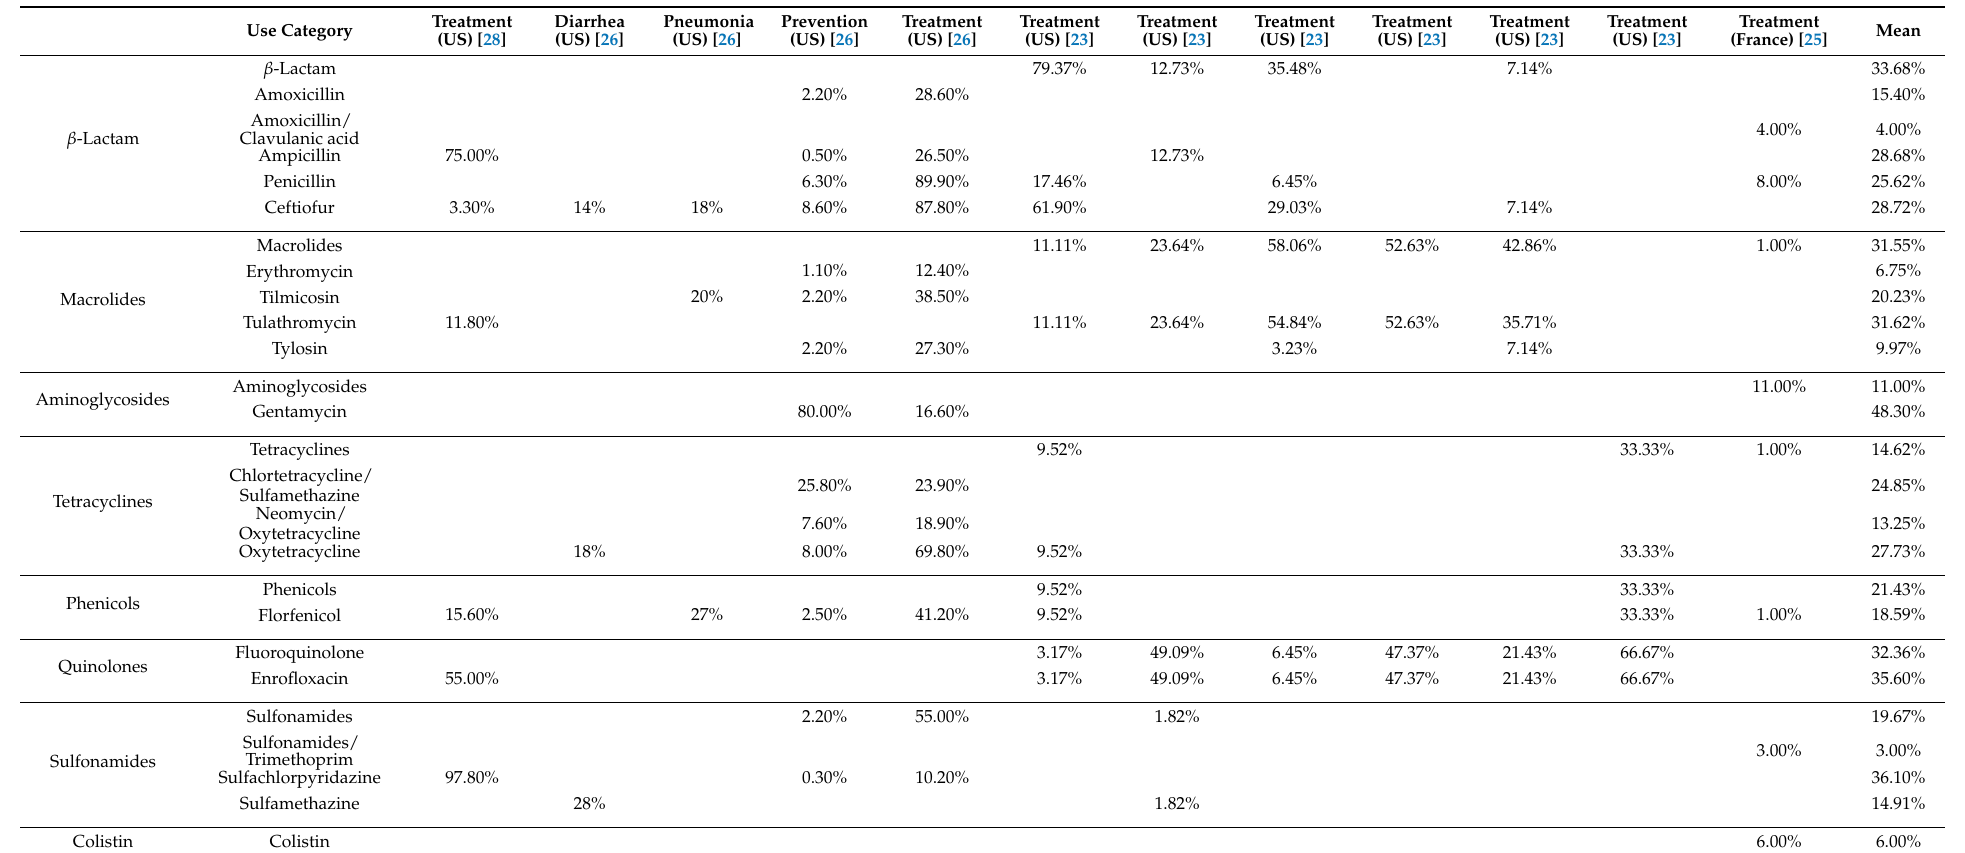
Table 3. Percentages of antimicrobials used for different purposes in dairy calves. Means were calculated as the arithmetic means of these percentages. There were three studies from the US and one study from